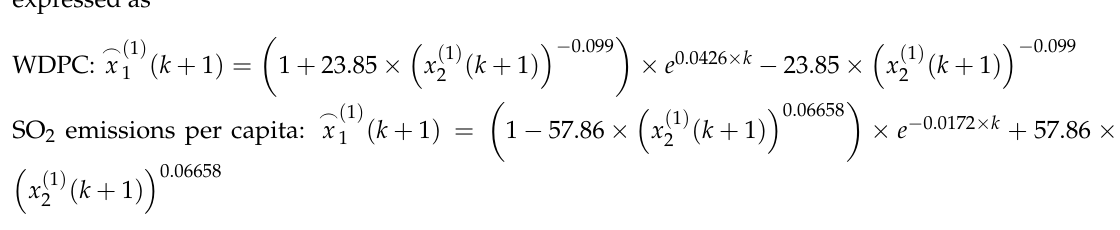
Each initial value is set as x expressed